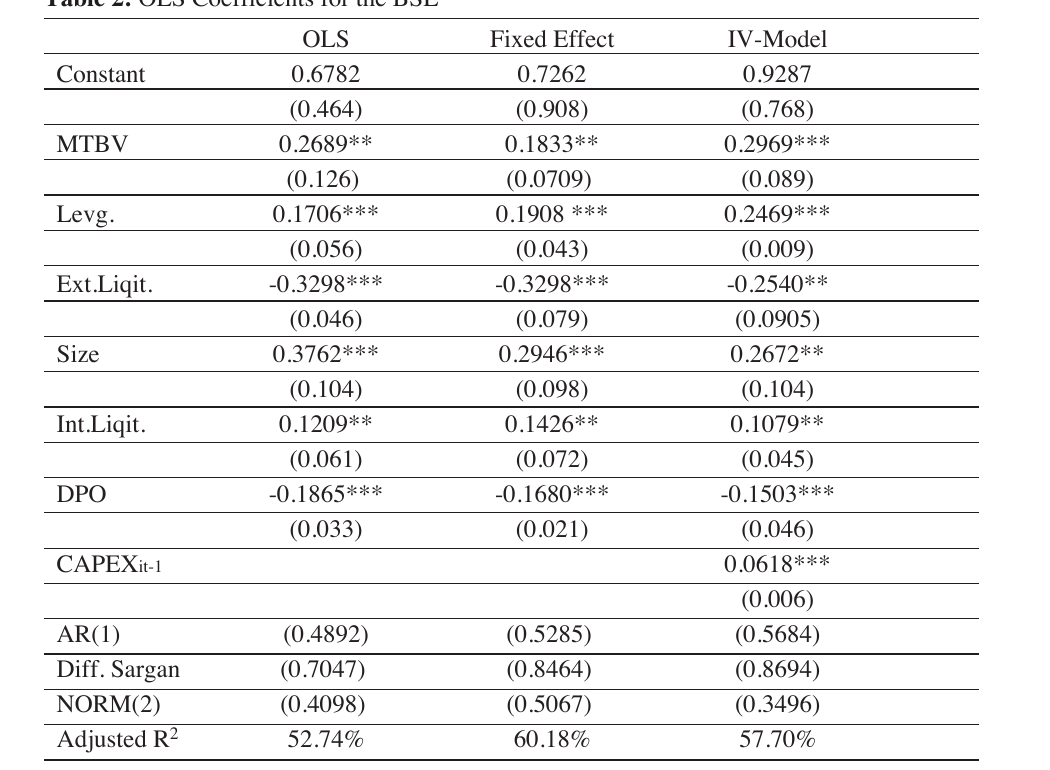
Table 2: OLS Coefficients for the